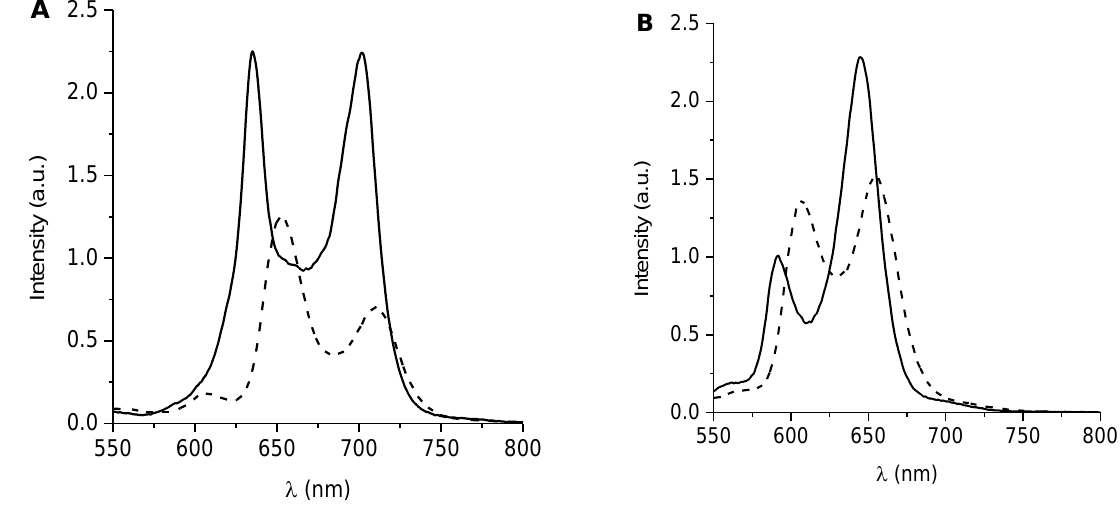
Figure 3. Fluorescence emission spectra of ( A ) TPPF 20 (solid line) and PTPPF 16 -EDA (dashed line) and ( B ) ZnTPPF 20 (solid line) and PZnTPPF 16 -EDA (dashed line) in DMF ( λ exc = 424 nm). Table 1. Spectroscopic and photodynamic properties of PSs in DMF.